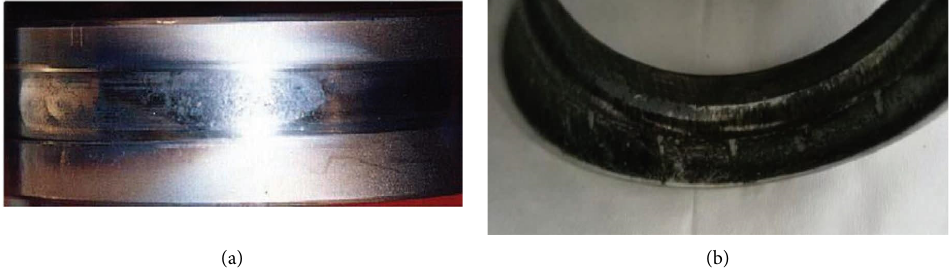
Figure 1: Bearing damage caused by thermal efect. (a) Bum of inner raceway. (b) Lubrication